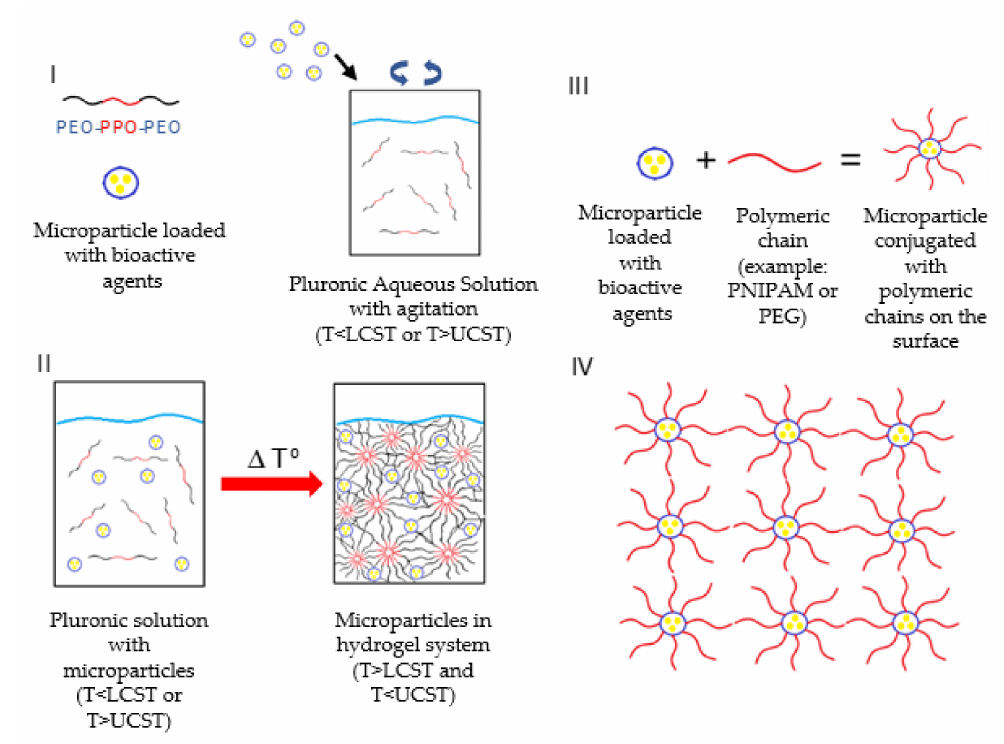
Figure 3. Thermoresponsive microparticles in Pluronic hydrogel system: ( I ) blending of Pluronic aqueous solution with microparticles, ( II ) microparticles in Pluronic hydrogel system gelation with particles evenly spread in the structure. Self-forming hydrogels with microparticles as cross-linking points: ( III ) the microparticles surfaces are conjugated with a polymeric chain (in red), ( IV ) the added chains will link to other chains forming a 3D structure with the microparticles serving as linking